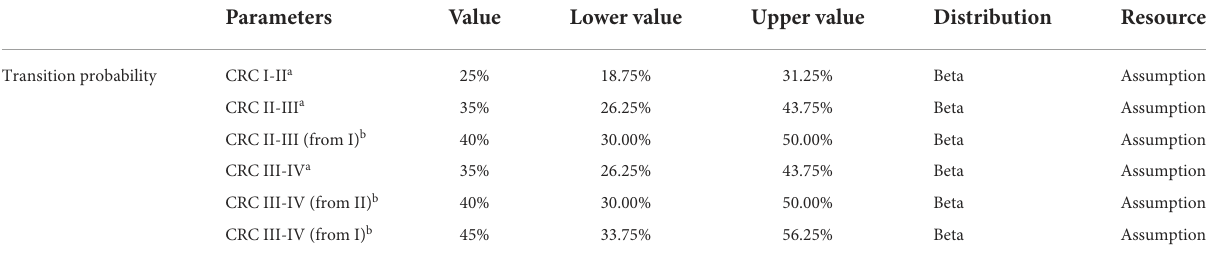
TABLE 3 Parameters in scenario